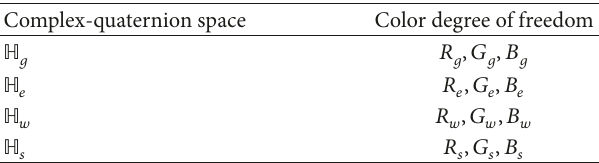
Table 7: There are twelve color degrees of freedom in the quantum mechanics described with the complex-sedenions, when the complex-sedenion quantum-field potential is degenerated into the classical complex-number wave functions of the conventional quantum